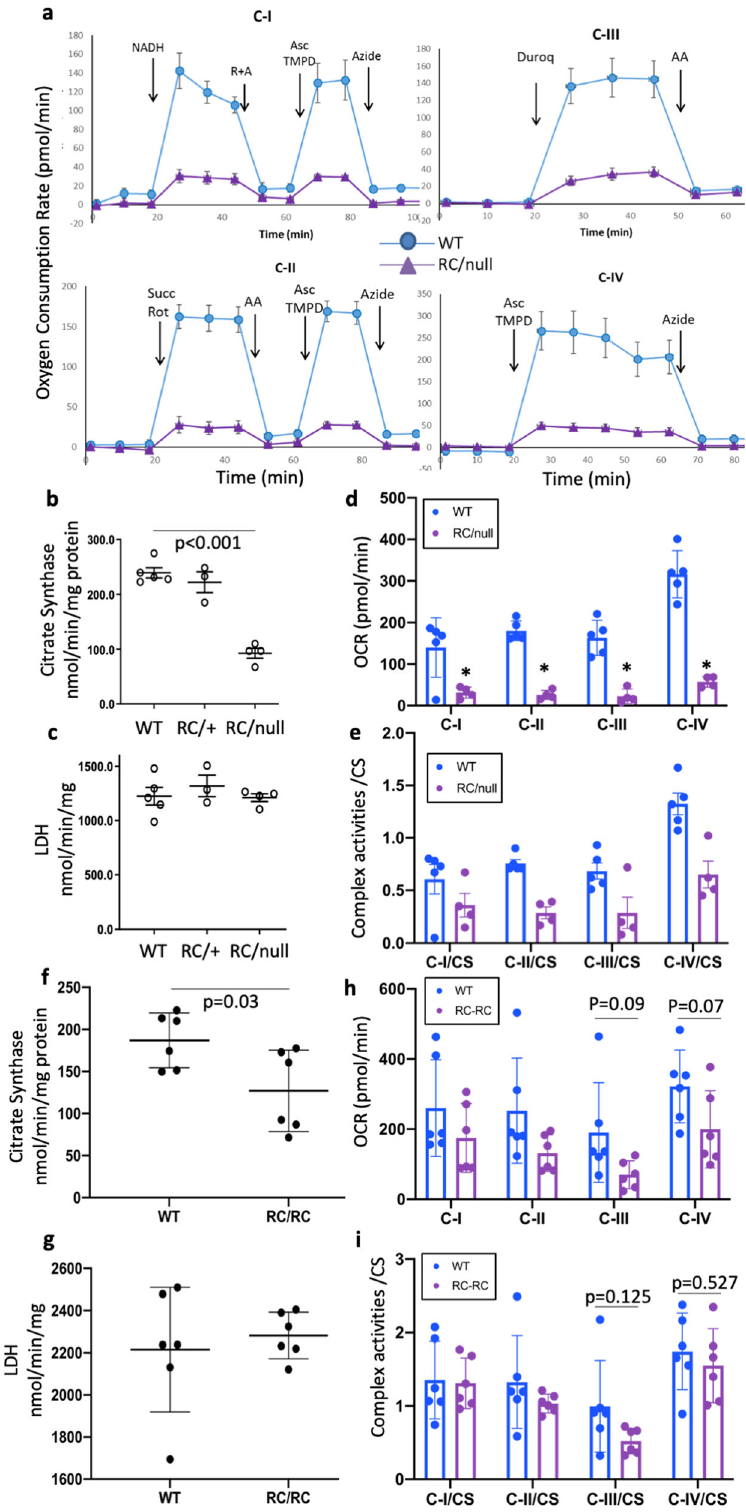
Mitochondrial targeted catalase (mCAT) attenuates kidney pathologies in two mouse models of ADPKD . RC/RC mice had enlarged kidneys at 6 − 7 month-of-age, and this was partially attenuated by low dose AAV9-mCAT injection (Fig. 3a). When normalized to body weight, kidney weight was signi fi cantly increased by ~60% in RC/RC mice compared with WT controls and this increase was attenuated by low dose AAV9-mCAT